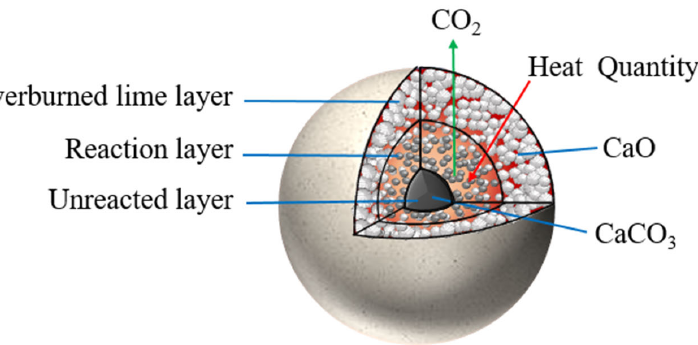
Figure 3. Schematic diagram of the decomposition of high-temperature calcined spherical calcium carbonate.